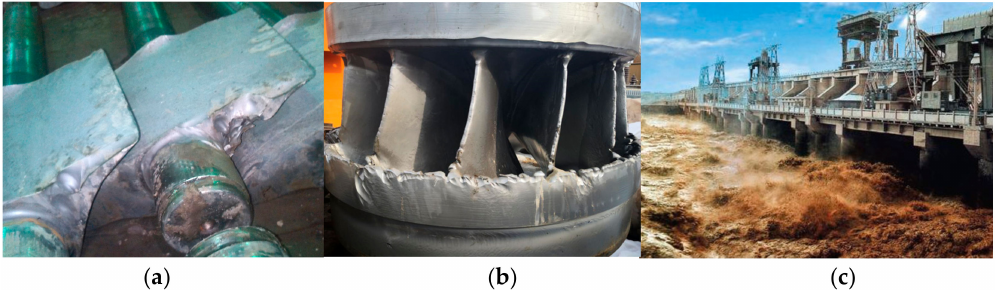
Figure 1. Sediment erosion in the flow passage components of the turbine: ( a ) Guide vane; ( b ) runner; and ( c ) hydropower station in a sand-laden river.